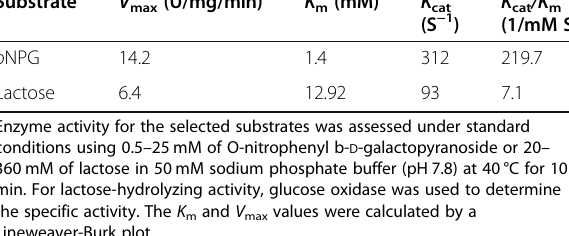
Table 5 Enzyme kinetics for the selected substrates Substrate